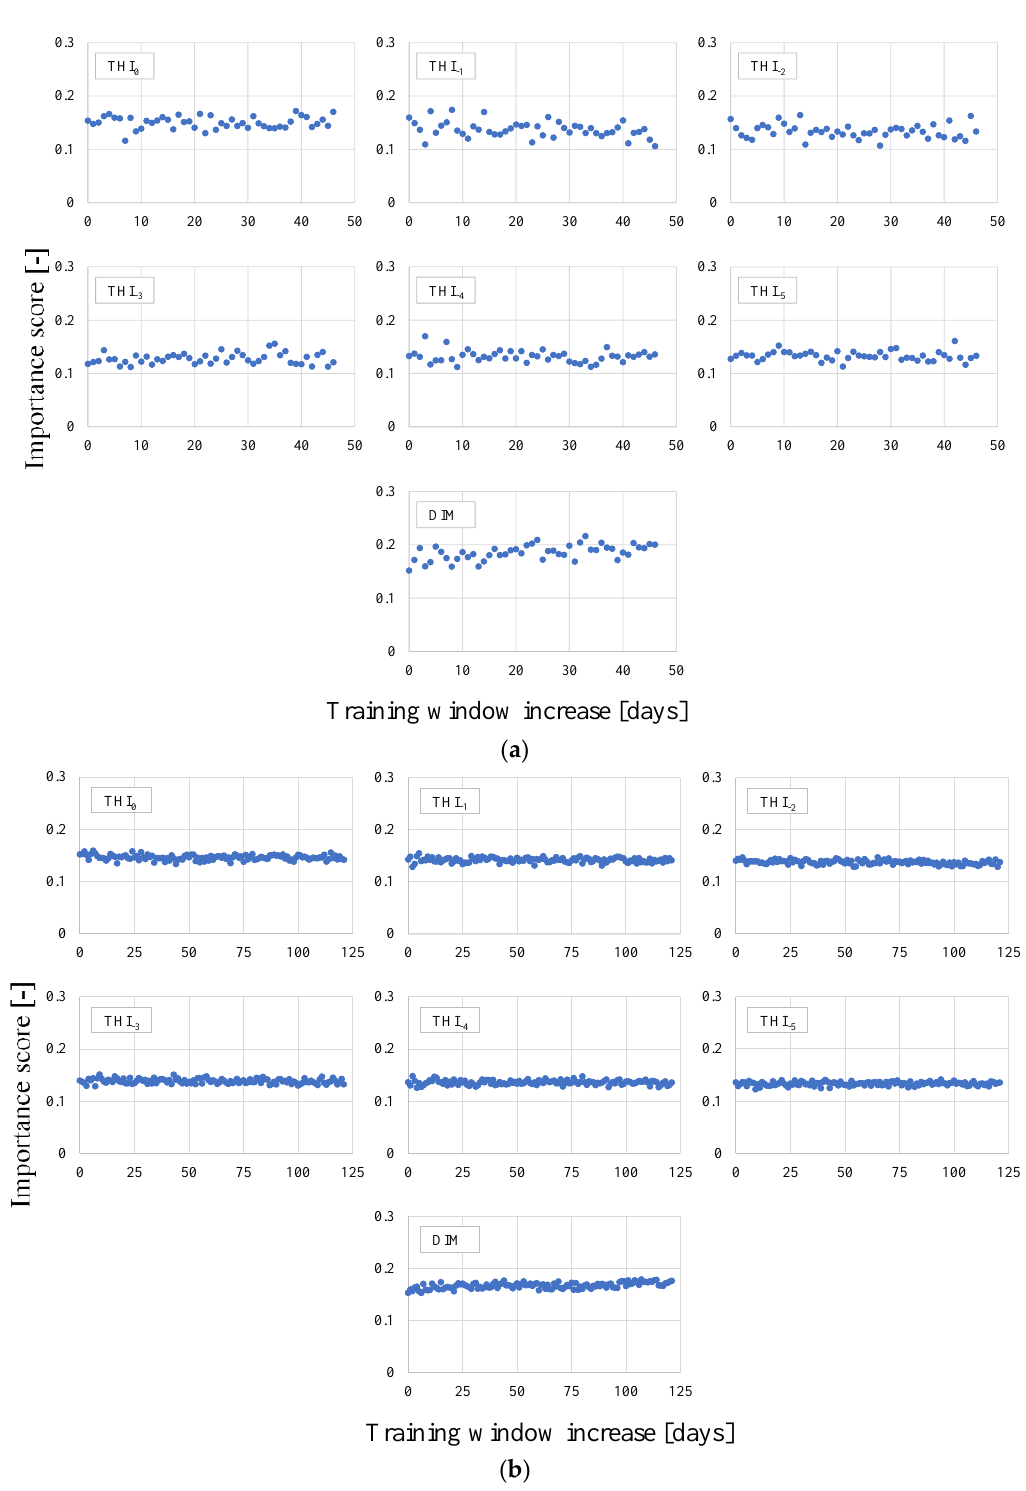
Figure 13. Trends of each importance score vs. training window increase for cows ( a ) #26 and ( b ) #85.